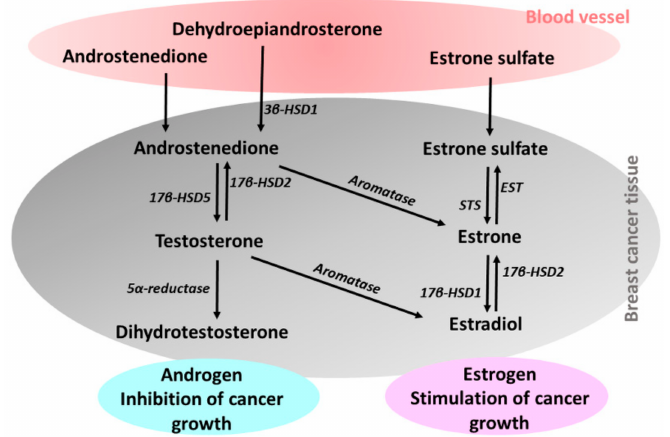
Figure 2. Schematic of steroid metabolism in breast cancer tissue. The bioactive steroids dehy- droepiandrosterone, androstenedione and estrone sulfate are formed from circulating inactive steroids by enzymes in steroid metabolism. STS, steroid sulfatase; EST, estrone sulfotransferase; 3 β -HSD1, 3 β -hydroxysteroid dehydrogenase type 1; 17 β -HSD1, 17 β -hydroxysteroid dehydroge- nase type 1; 17 β -HSD2, 17 β -hydroxysteroid dehydrogenase type 2; 17 β -HSD5, 17 β -hydroxysteroid dehydrogenase type 5. Modified and redrawn according to Suzuki et al.